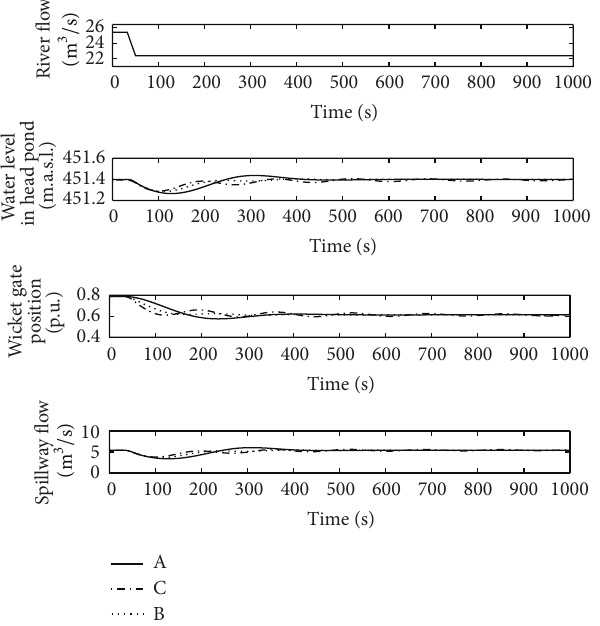
Figure 12: River flow, wicket gates position, water level in the head pond, and spillway flow, in normal operation (points A, B, and C).